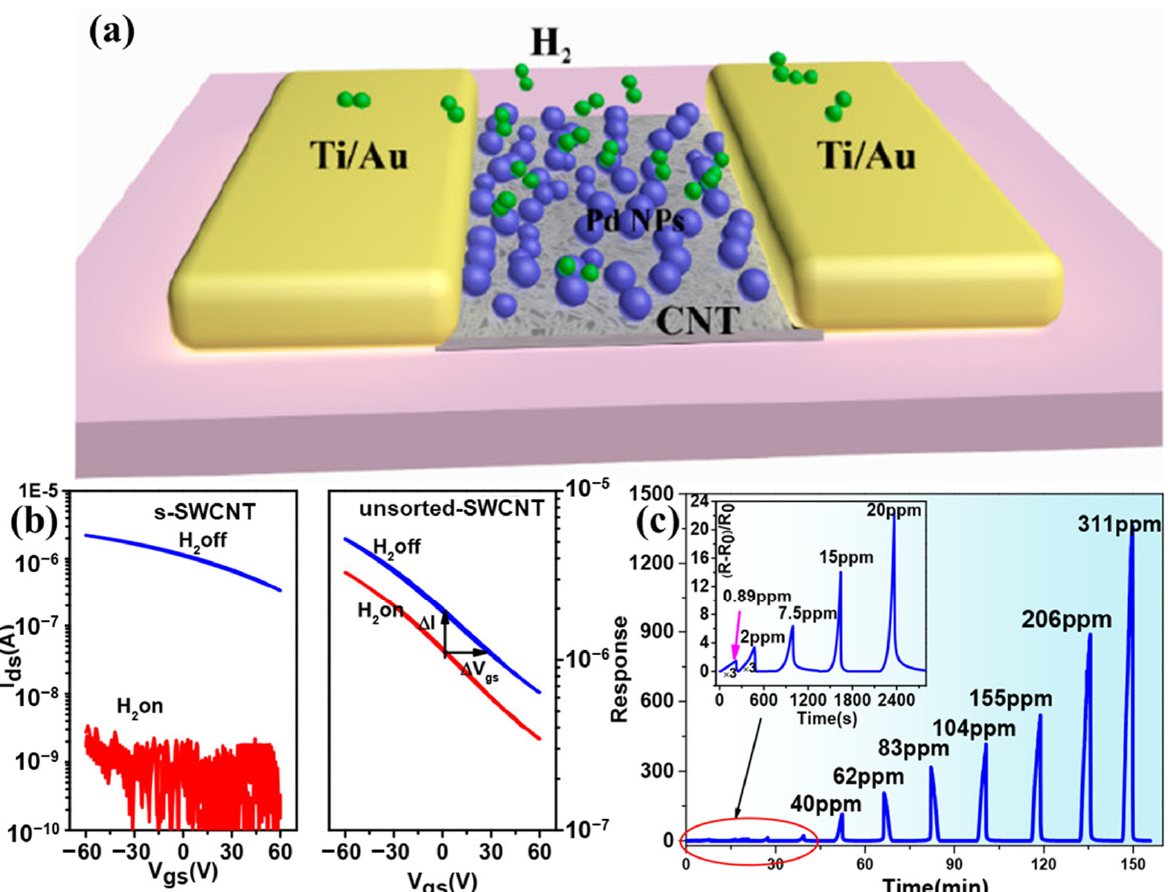
Figure 11. ( a ) Schematic of a H 2 sensor based on a SWCNT film decorated with Pd. ( b ) Transfer curves of the sensors based on s-SWCNTs (left) and unsorted-SWCNTs (right) before (blue) and after (red) 311 ppm of H 2 exposure for 200 s. ( c ) Real-time response to different H 2 concentrations at room temperature. Inset: magnified plot at low concentrations. Reprinted with permission from Ref.